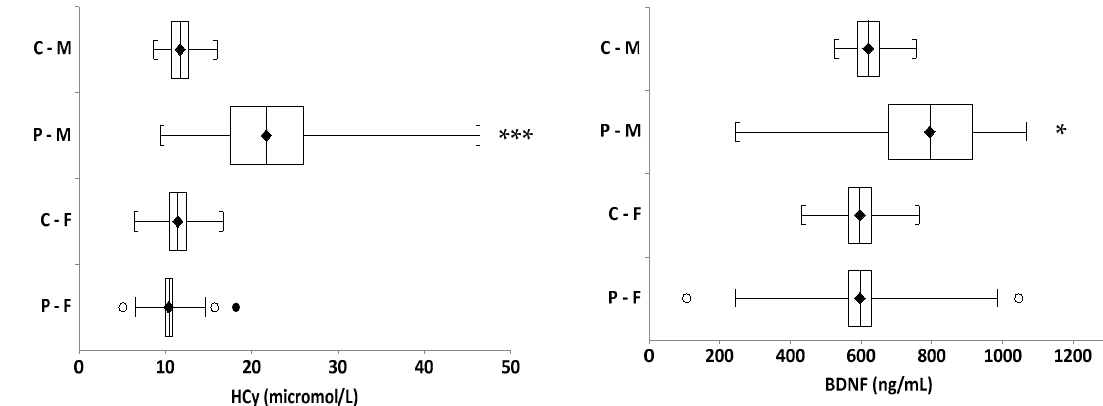
Nutrients 2021 , 13 , x FOR PEER REVIEW Figure 1. Levels of brain-derived neurotrophic factor (BDNF) and homocysteine (HCy), by gender, at the baseline. C = controls, P = patients, M = male, F = female; • outer fence for outlier, ◦ inner fence for outlier, * p < 0.05, *** p < 0001.